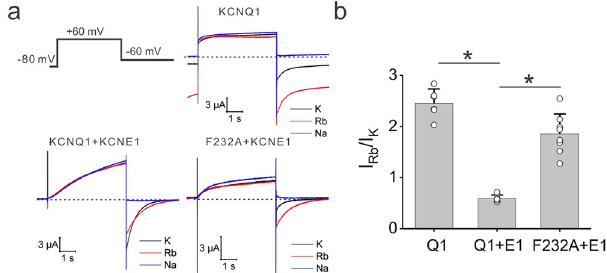
Fig. 3 F232A changes the Rb + /K + permeability ratio of KCNQ1/KCNE1 channels. a Current traces from oocytes expressing KCNQ1, KCNQ1/ KCNE1, and KCNQ1-F232A/KCNE1 channels under high external K + (black), Rb + (red), and Na + (blue) concentration. Dashed lines indicate zero currents. Cells are held at − 80 mV and stepped to + 60 mV followed by a step to − 60 mV. Note that KCNQ1 channels do not close completely at negative voltages. b Comparison of measured tail Rb + /K + ratio from the KCNQ1 ( n = 6), KCNQ1/KCNE1 ( n = 8), and KCNQ1-F232A/KCNE1 ( n = 7) channels. Data are shown as mean ± SEM, * P < 0.05. P = 4.09349E-10 between KCNQ1 and KCNQ1/KCNE1 channels. P = 3.57806E-07